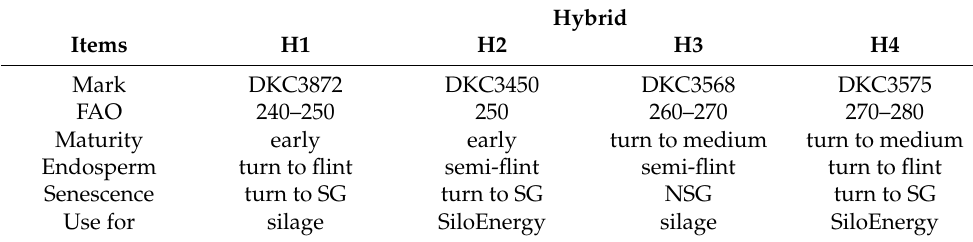
Table 1. Basic characteristics of tested hybrids.